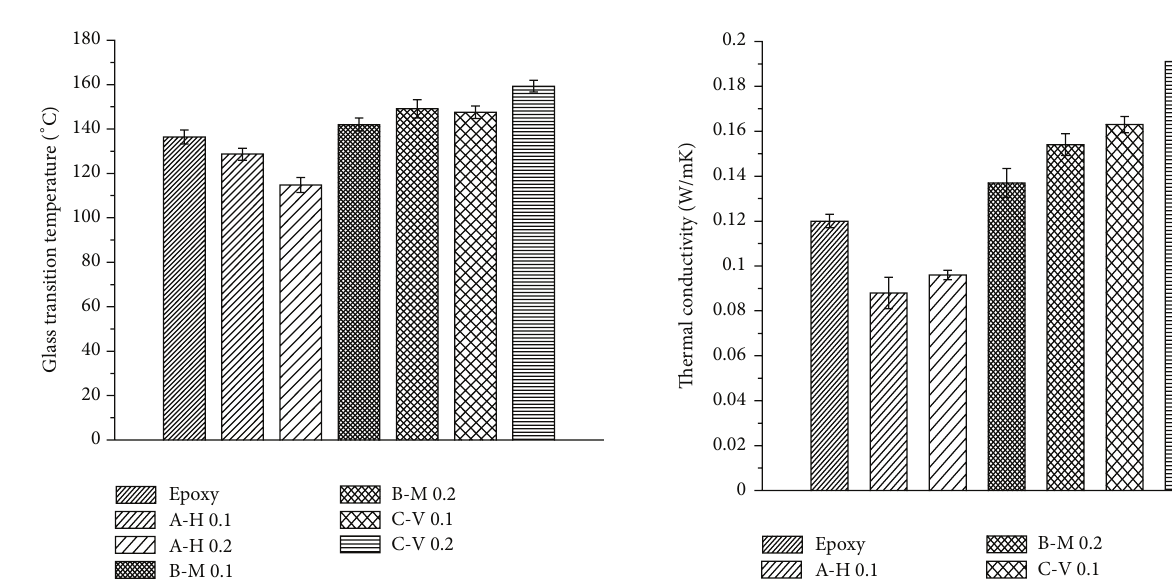
Figure 4: Glass transition temperature of the test samples.